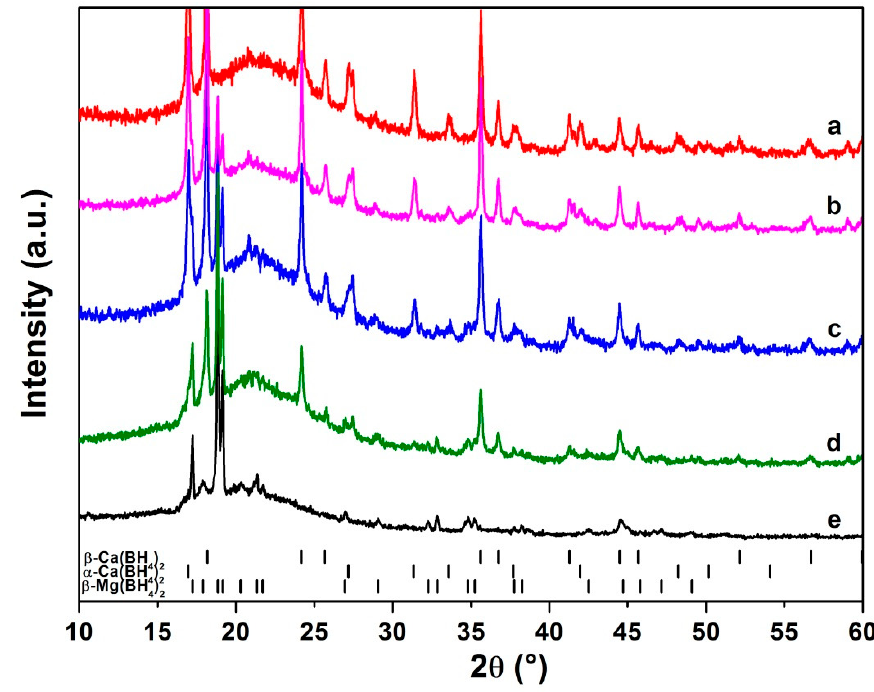
Figure 4. Room temperature PXD pattern of (a) Ca(BH 4 ) 2 , (b) 1Mg(BH 4 ) 2 : 2Ca(BH 4 ) 2 , (c) 1Mg(BH 4 ) 2 : 1Ca(BH 4 ) 2 , (d) 2Mg(BH 4 ) 2 : 1Ca(BH 4 ) 2 and (e) Mg(BH 4 ) 2 after DSC cycling up to 210 °C under 2 bar of H 2 . Table 1. Onset and peak temperatures of α - β polymorphic transition, decomposition, and re- hydrogenation of pure Mg(BH 4 ) 2 , Ca(BH 4 ) 2 and their mixtures (2:1, 1:1, 1:2 molar ratio), obtained in